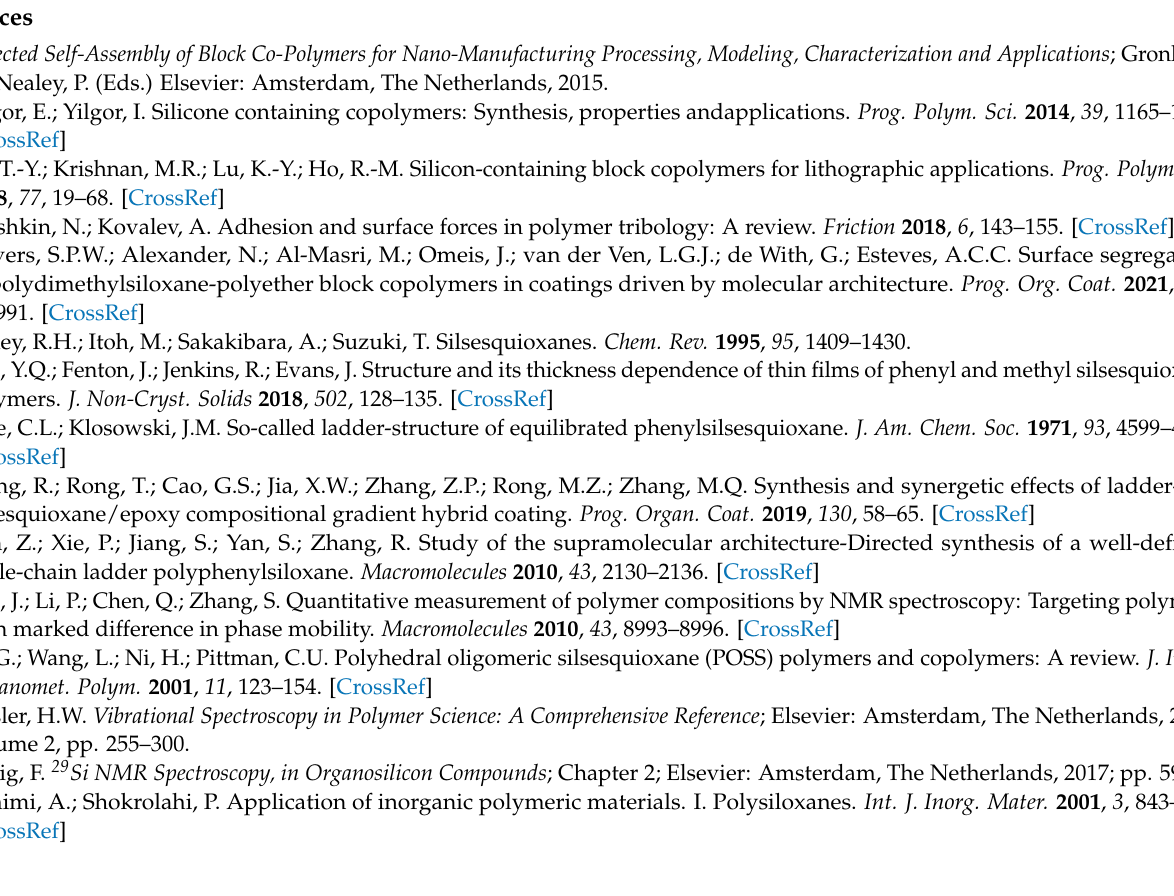
Figure S2: 19F NMR spectrum of copolymer V in CDCl3 solution, Figure S3: 29Si NMR spectrum of copolymer IV in CDCl3 solution, Figure S4: 29Si NMR spectrum of copolymer V in CDCl3